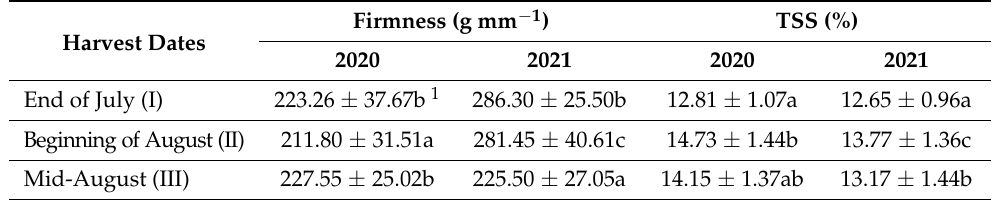
Table 12. Impact of harvest time on several quality parameters of highbush blueberry fruit in 2020 and 2021. Harvest